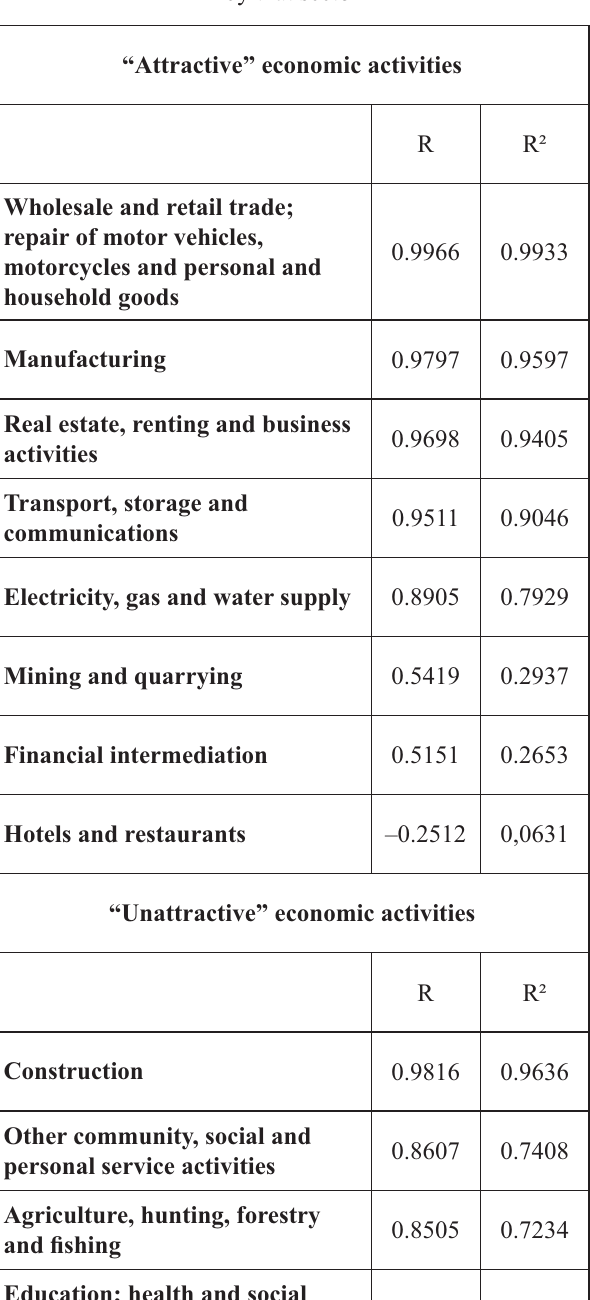
Table 1. The results of correlation-regression analysis between FDI into specifi c sector and GDP generated by that